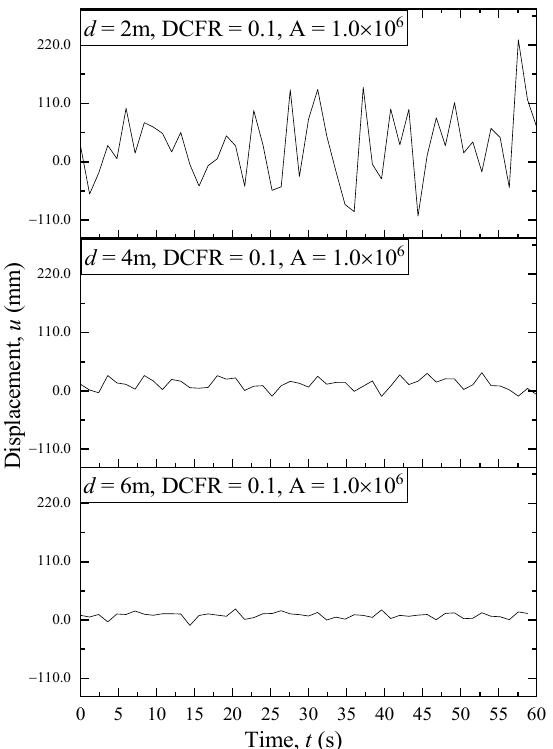
Figure 5. Sensitivity analysis of the diameter of LOSP.